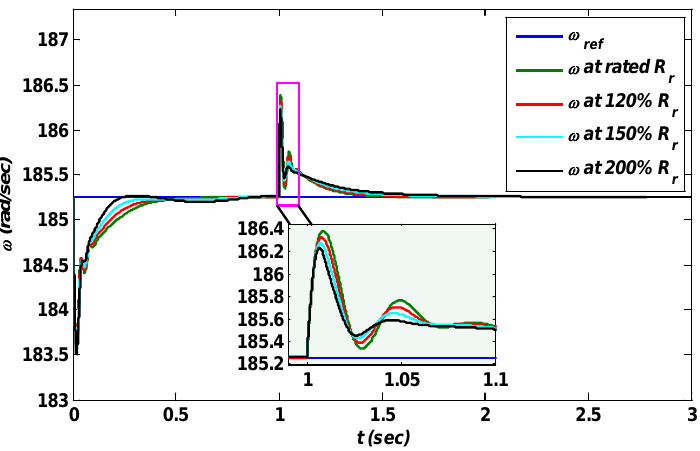
Figure 12. Speed control of indirect field oriented control IM using adaptive PI.